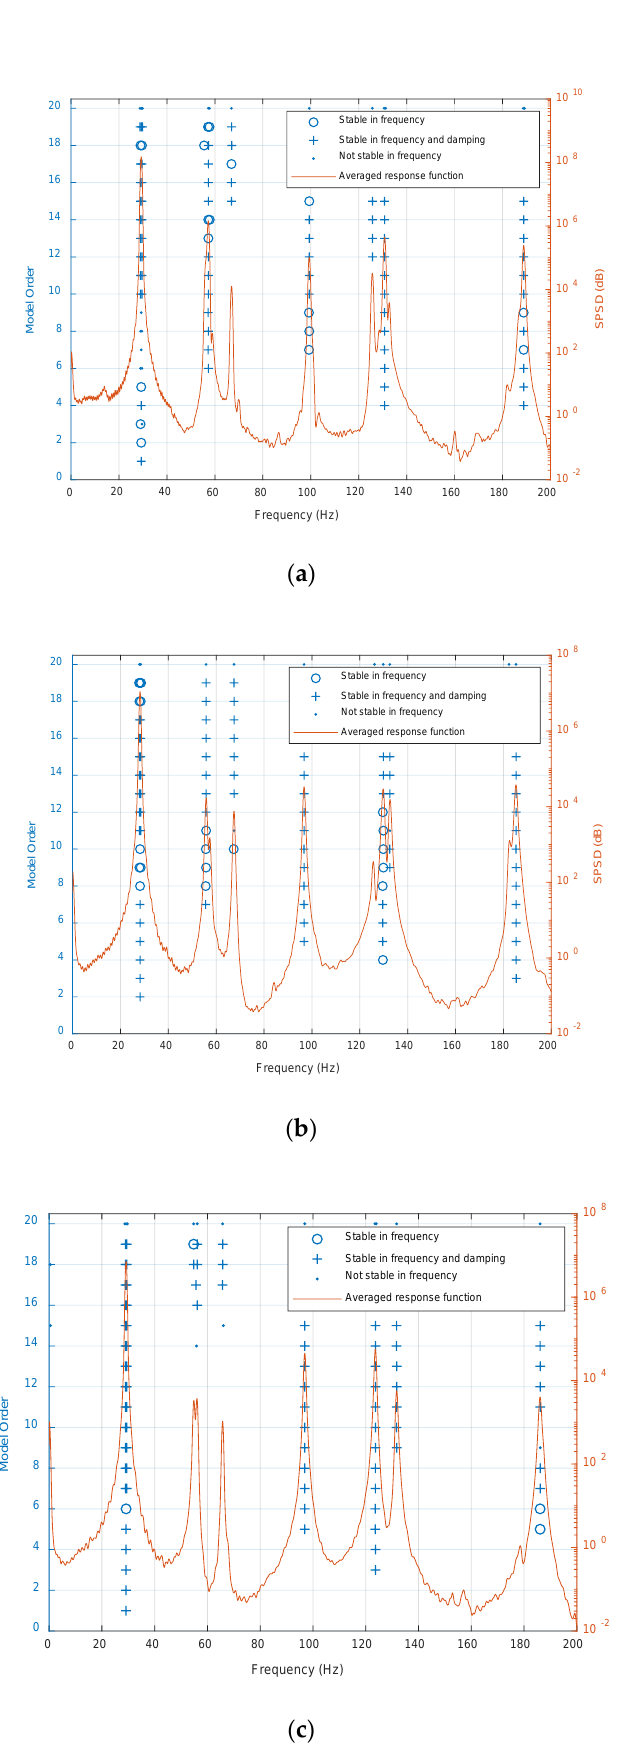
Figure 9. Stabilization diagrams of ( a ) plate A, ( b ) plate B and ( c ) plate C.